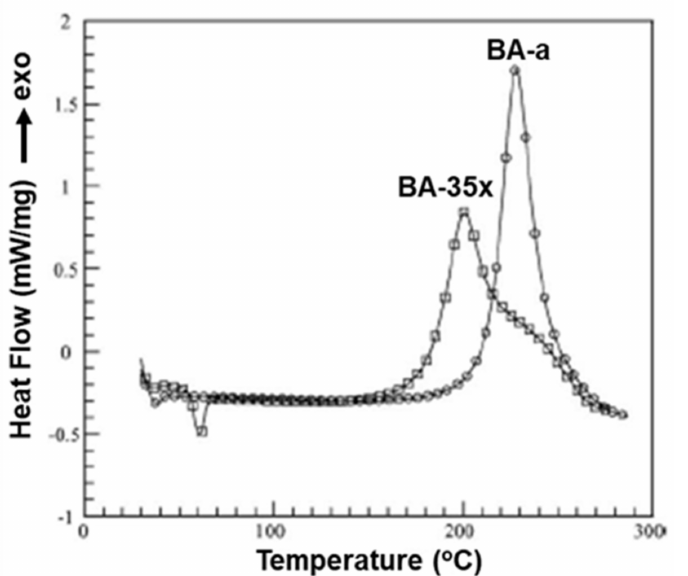
Figure 10. DSC thermograms of BA-a and ( ◦ ) BA-35x ( (cid:3) ) [165]. Copyright 2006. Reproduced with permission from Elsevier